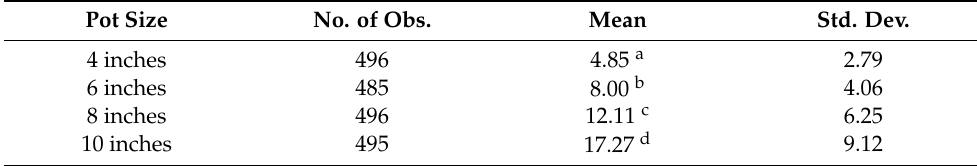
Means denoted by a different letter indicate significant differences between pot sizes ( p ≤